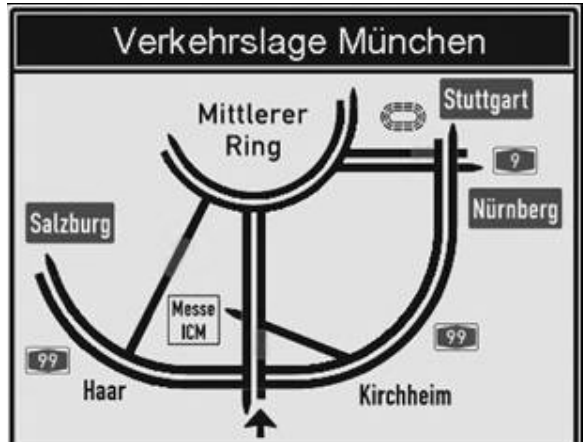
Figure 1b. Example of a Graphical Sign in Germany (a black default setting may be changed to red according to congestion